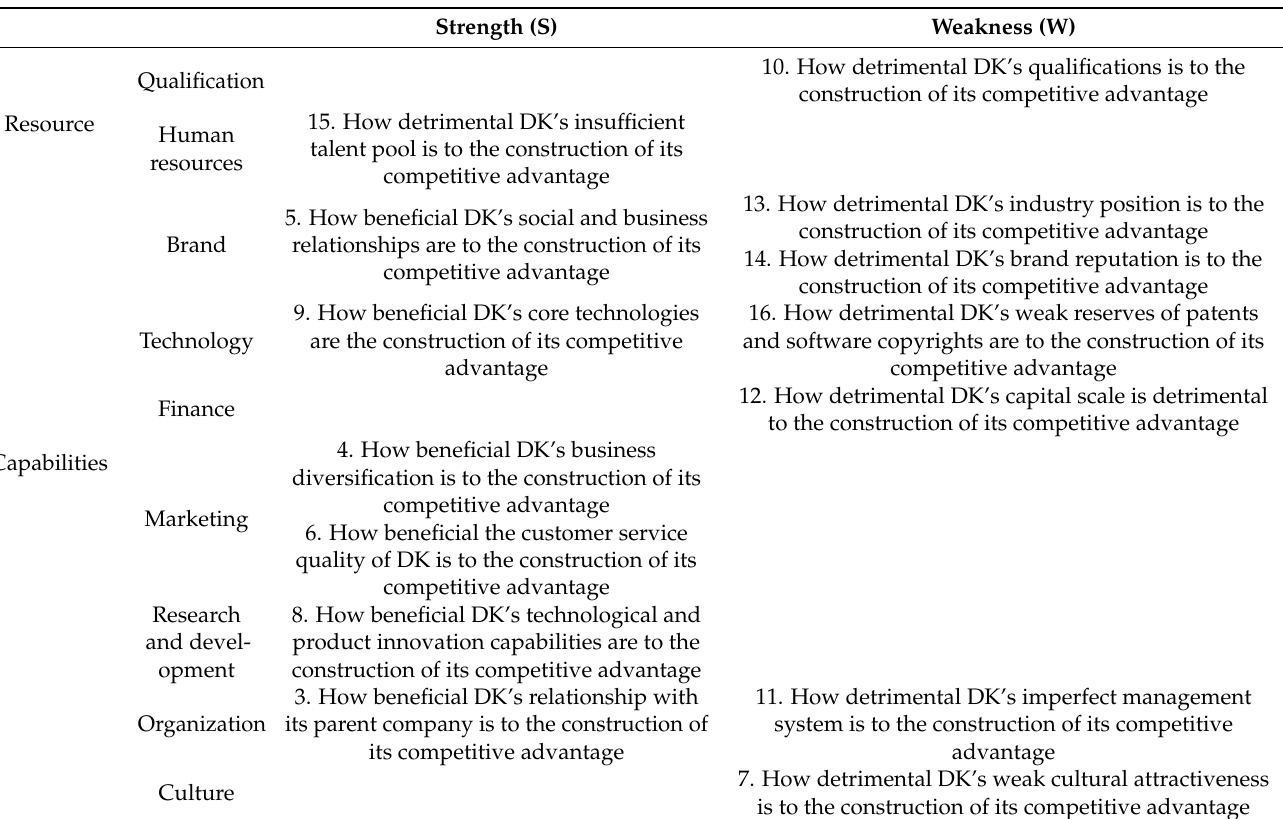
Table A1. Internal condition-oriented DK questionnaire